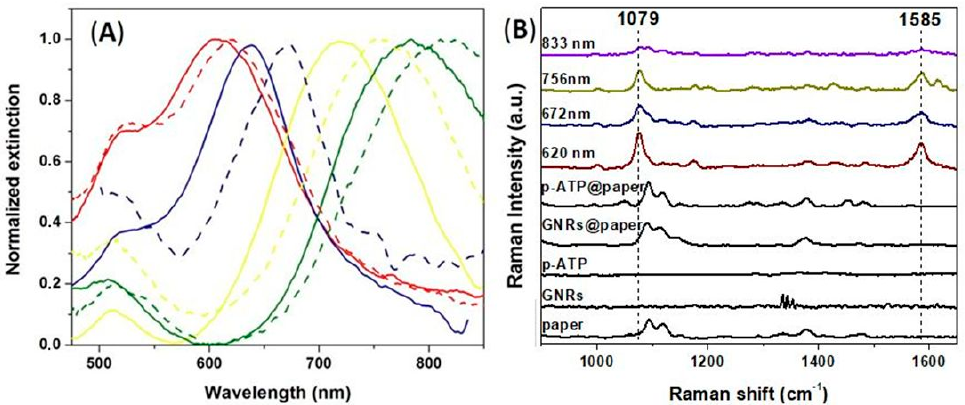
Figure 4. ( A ) Normalized extinction spectra of the GNRs immobilized onto the paper before (solid lines) and after (dotted lines) dropping the p-ATP analyte; ( B ) SERS spectra of the p-ATP molecules adsorbed onto fabricated tunable paper based plasmonic nanoplatforms; the black lines represent the Raman spectrum of Whatman paper No. 1., colloidal GNRs, p-ATP analyte alone (10 − 4 M), GNRs immobilized on paper, and free p-ATP 10 − 4 M dropped onto the bare paper, respectively; excitation laser line used: 785 nm.